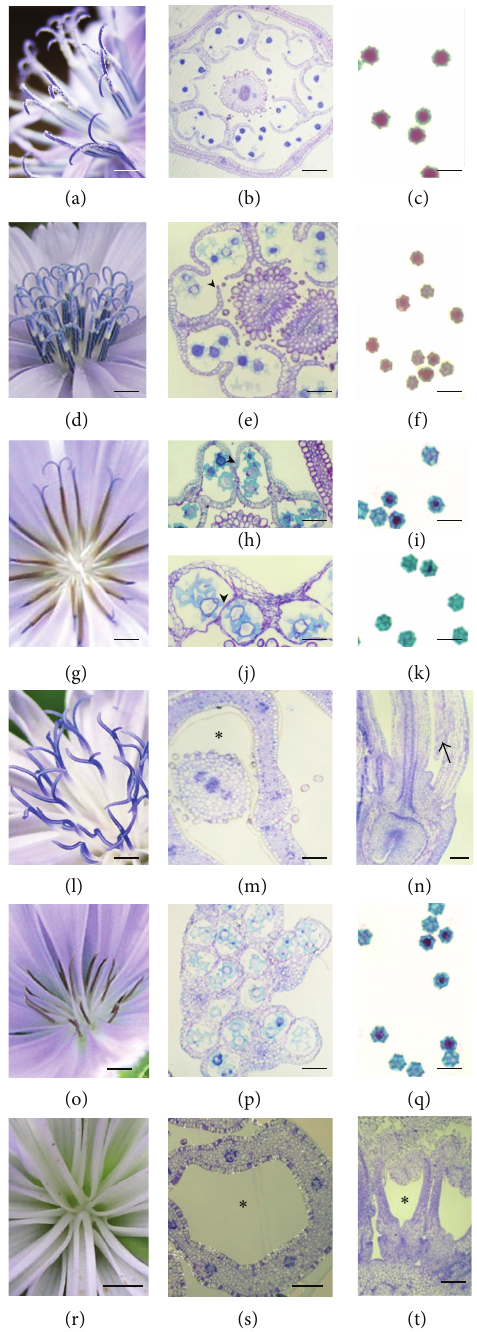
Figure 6: Morphology of flowers and pollen viability in the parents and progenies of crosses with CC and Jupiter pollen donors. (a)–(c) Male fertile flowers: the anthers are blue and the stigma brushing hairs collect pollen grains at anthesis (a). Anther dehisces normally (b) and pollen grains are viable (c). (d)–(f) Class 1: the anthers are blue and the pollen grains collected can be seen on the stylar branches (d). Anthers are dehiscent in (e) (arrow head) but pollen viability is reduced (f). (g)–(k) Class 2: the anthers are brown; the pollen grains are not collected as it can be noticed on the stylar branches and the style. In subclass 2a ((h)-(i)) the septum and stomium are disrupted but the opening of locules is not well achieved (arrow head in (h)) and most of pollen grains are not viable (i). In subclass 2b ((j)-(k)) the anthers remain indehiscent and the locule wall is shrunken (arrow head), no lignification of endothecium and connectivum (j) and the pollen grains are not viable (k). (l)–(n) Class 3: the pistil morphology is normal (l), cross section in the mature floret shows that no stamen develops ( ∗ in (m)), and longitudinal sections of some florets show some stamen initiation but no differentiation (arrow in (n)). (o)–(q) Class 4: no style is observed (o). The anthers are indehiscent and stacked together (p). Nonviable pollen is shown in (q). (r)–(t) Class 5: no anther and style emerge in the corolla tube ( ∗ in (r) and (s)). Longitudinal section of young floret buds shows that stamens and carpels are not initiated ( ∗ in (t)). Bars (a), (d), (g), (l), (o), and (r) 2 mm; (b), (e), (h), (j), (m), (n), (p), (s), and (t) 100 𝜇 m; (c), (f), (i), (k), and (q) 50 𝜇